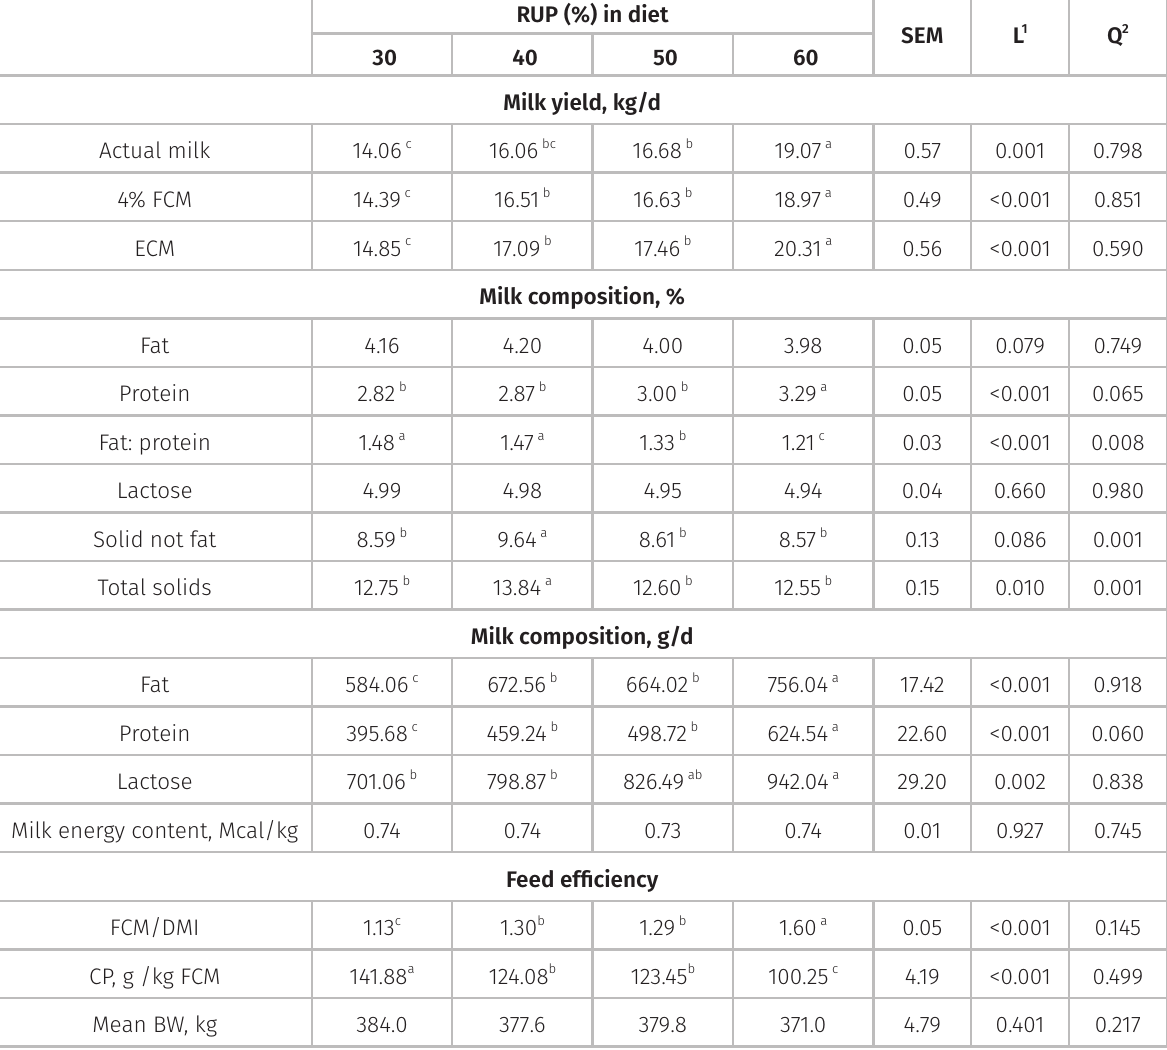
Table V. Feed efficiency, milk yield and its composition of cross bred (Friesian×Jersey) dairy cattle fed diets with various levels of rumen undegradable protein